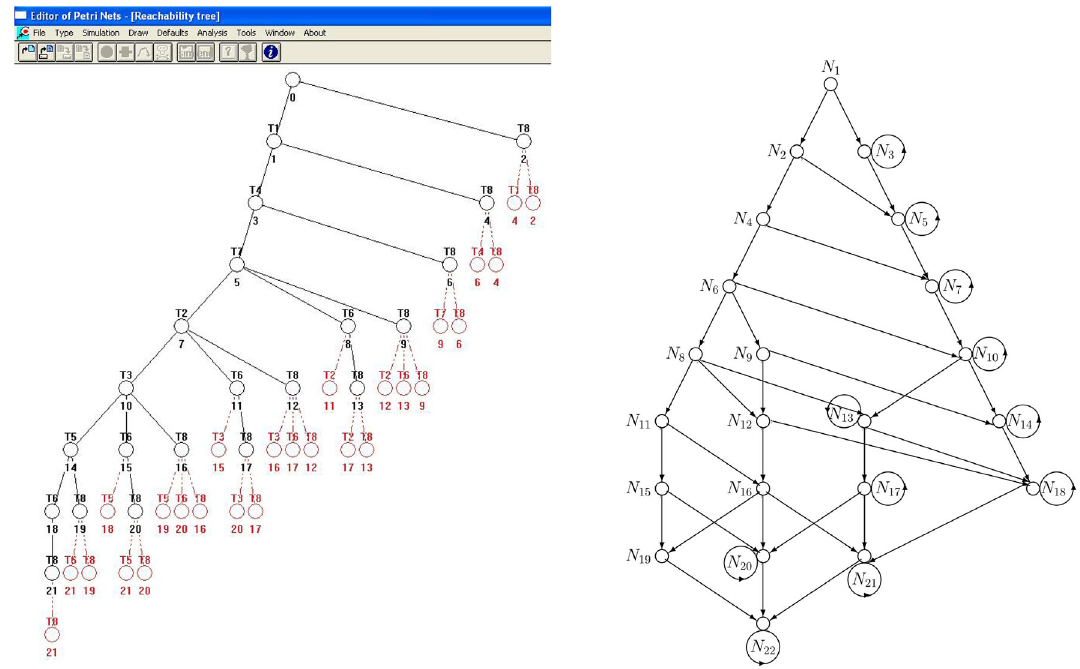
at the infinite number of possible occurrences of the 5